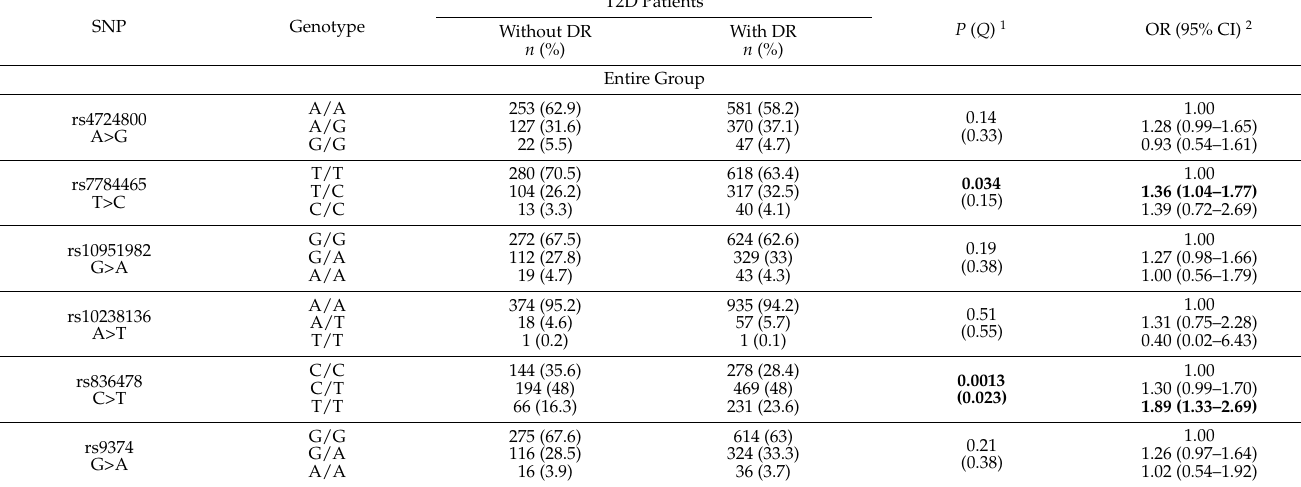
Table 2. Genotype frequencies for the RAC1 gene polymorphisms in T2D patients with and without diabetic retinopathy